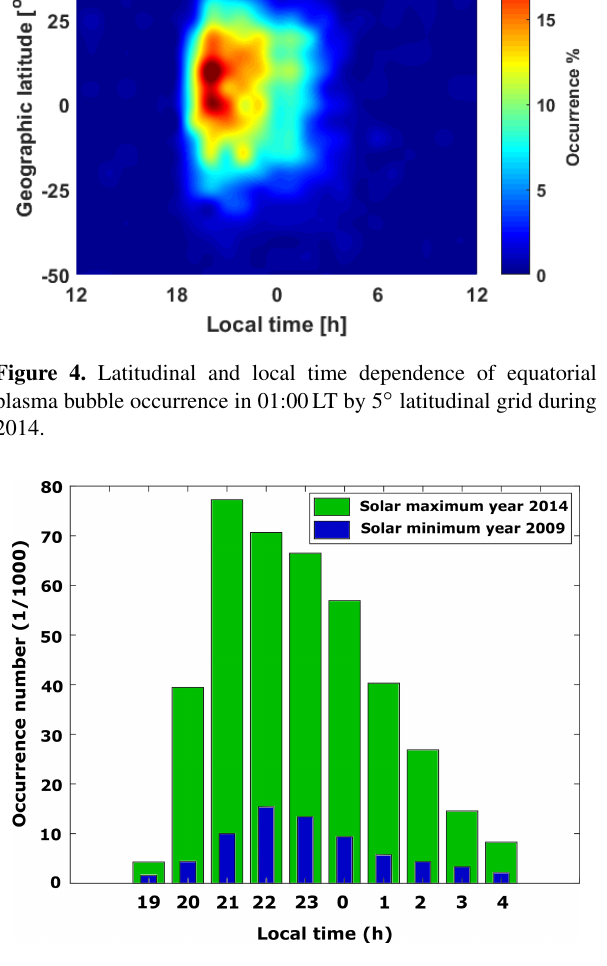
Figure 5. Occurrence of plasma bubbles based on local time during the solar minimum year (2009) and solar maximum year (2014),